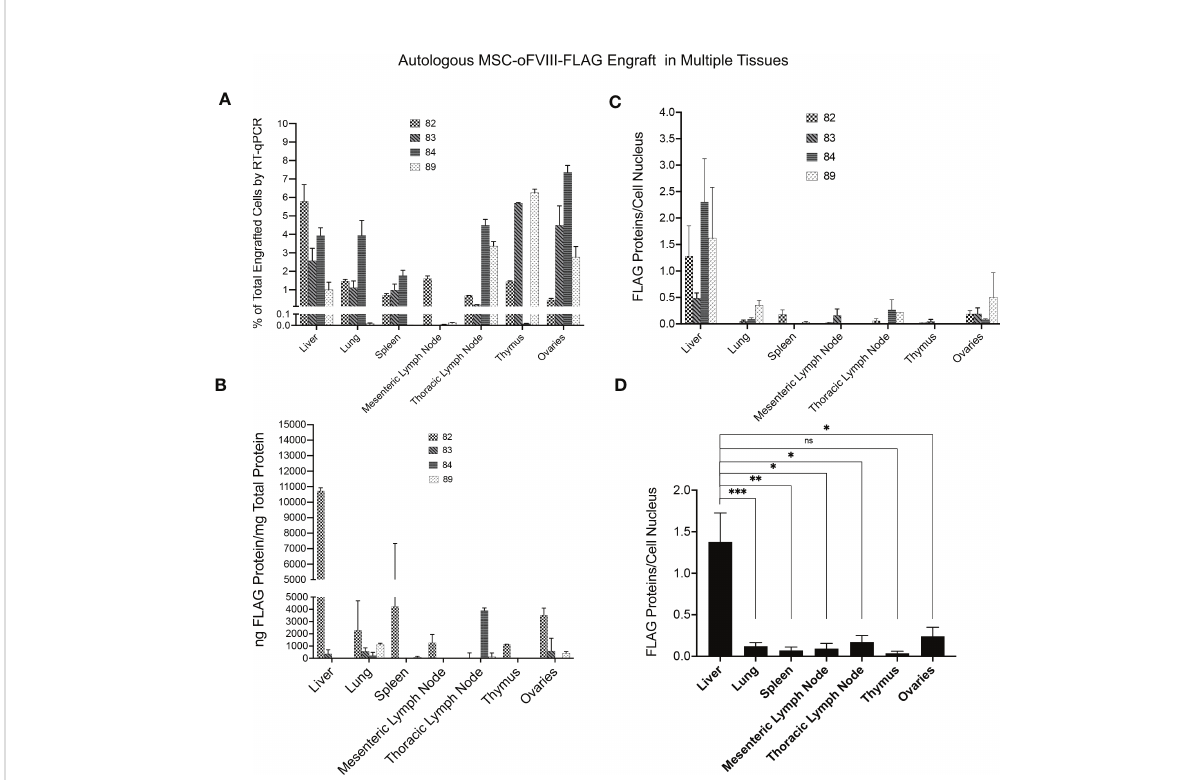
FIGURE 5 Quanti fi cation of Autologous MSC-oFVIII-FLAG Engraftment in Multiple Tissues by RT-qPCR, FLAG-speci fi c ELISA, and Immunohistochemistry. (A) RT-qPCR was performed (n=3/organ/animal) using FLAG-tagged oFVIII speci fi c primers on RNA isolated from different organs, and the percentage of MSC-oFVIII-FLAG engraftment was extrapolated using a standard curve prepared with RNA isolated from different percentages of MSC-oFVIII-FLAG mixed with sheep non-transduced MSCs. MSC-oFVIII-FLAG engrafted at detectable levels in each animal in every tissue examined. (B) Levels of oFVIII-FLAG protein in each tissue were determined by performing FLAG-speci fi c ELISA on tissue homogenates, and the highest levels of oFVIII-FLAG protein were found in the liver of the treated animals (n=4 biologic replicates; n=3 technical replicates). (C) Immunohistochemistry with an antibody to the FLAG-tag protein was also performed in the various tissues to con fi rm the presence of oFVIII-FLAG in the different tissues; particle analysis in imageJ was used to quantify the total number of cells and the amount of FLAG protein to determine the quantity of FLAG protein per cell, and these analyses showed a pattern of engraftment similar to that found by ELISA. (D) Levels of oFVIII-FLAG protein were signi fi cantly higher in the liver of the recipients than any other tissue (n=4 biologic replicates; n=3 technical replicates; *p < 0.05, **p < 0.005, ***p < 0.0005). ns, not signi fi